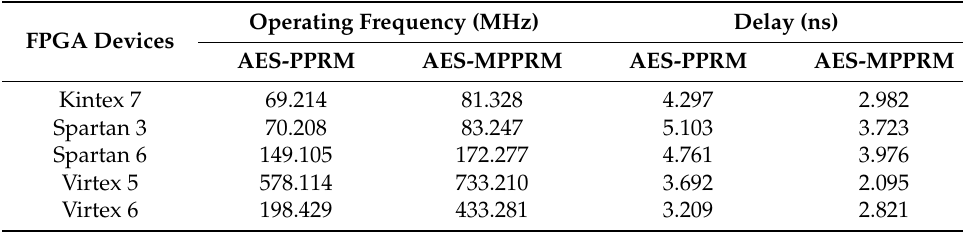
Table 6. Analysis of operating frequency and delay for